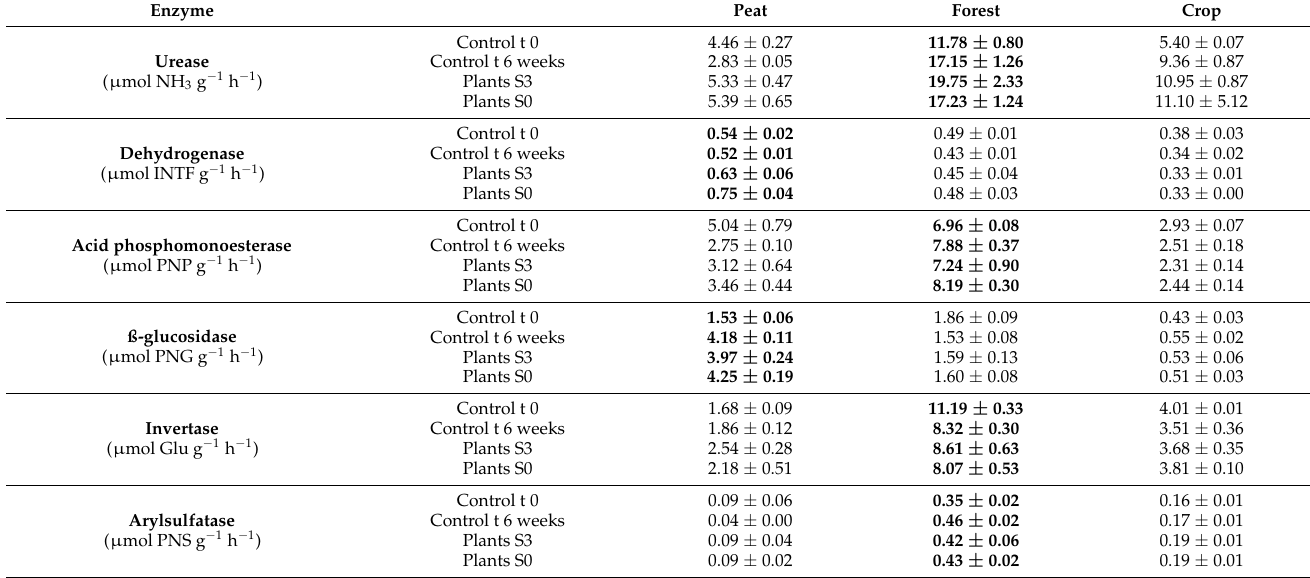
Table 2. Effect of the type of soil, the time of sampling and the presence of plants on enzymatic activi- ties of peat, forest and crop soil used for willow acclimation. Values are presented as mean ± standard deviation of 5 samples per soil for the 2 controls and 20 samples per soil and sucrose treatment for the soils with plants. Control t0: control without plants at time 0 (when the plants were transferred to different soils); Control 6w: control without plants after 6 weeks; Plant S0/S3: samples with plants micropropagated with 3% sucrose or without sucrose after 6 weeks of planting. Bold numbers indicate the soil with highest enzymatic activity for each